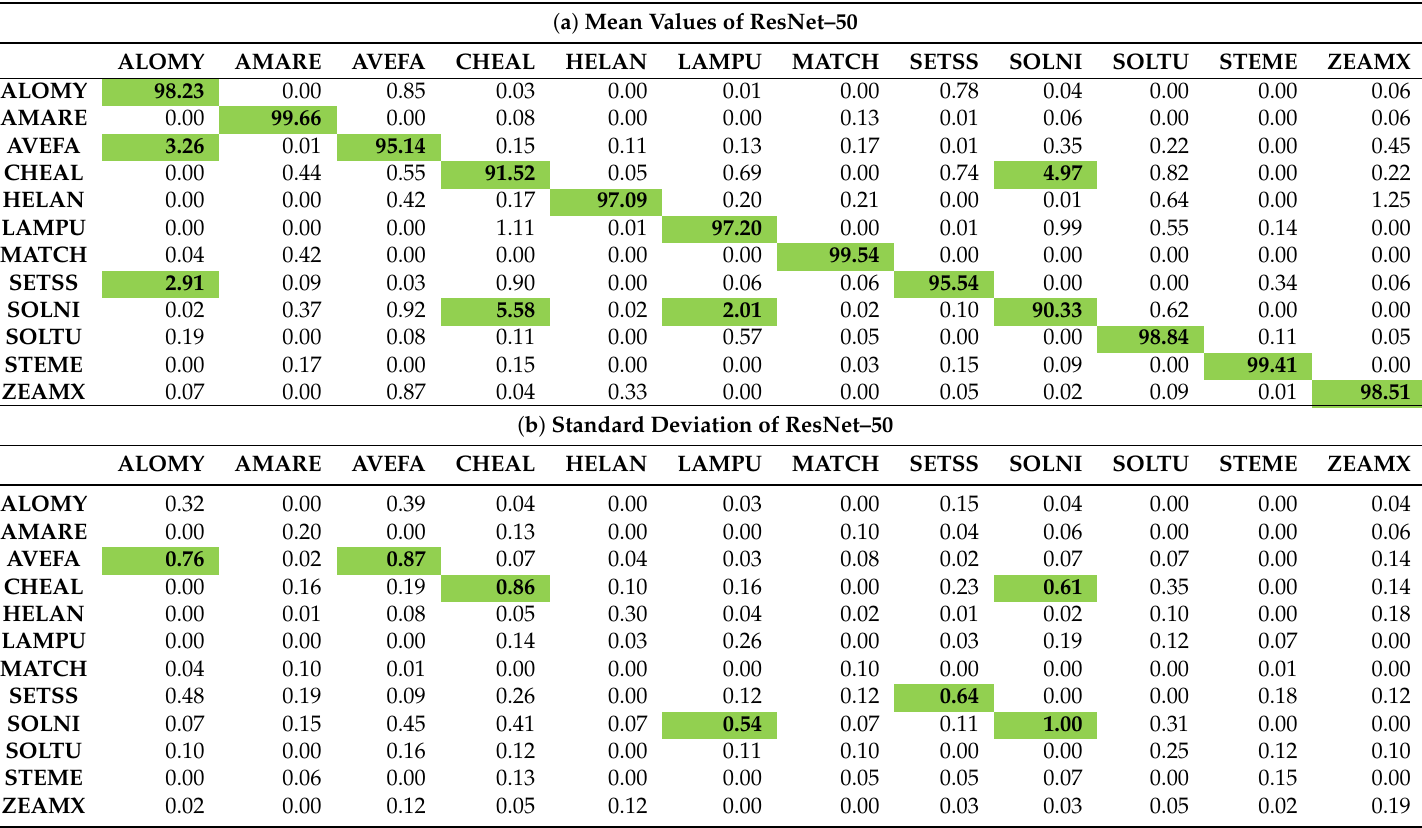
Table 4. Confusion matrix of the mean crop and weed identification for the ResNet–50 Convolutional Neural Network. The prediction reached between 97.2 and 97.7 % top-1 accuracy on the test dataset. The values are the percentage of identified labels for each plant species (Each row sums to 100%). ( a ) Mean values for the ten training runs. Cell values above 2% are highlighted. ( b ) Standard deviation for the ten training runs. The standard deviation values above 0.5% are